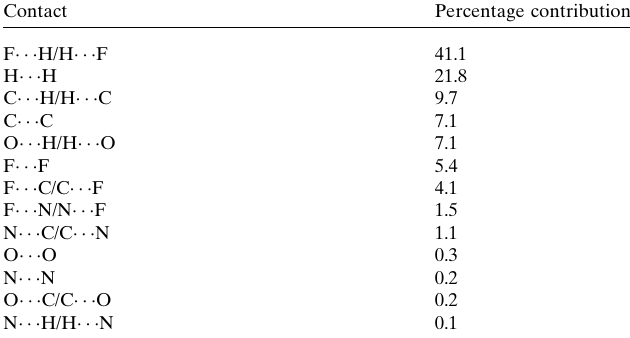
Table 2 Percentage contributions of interatomic contacts to the Hirshfeld surface for the title compound.